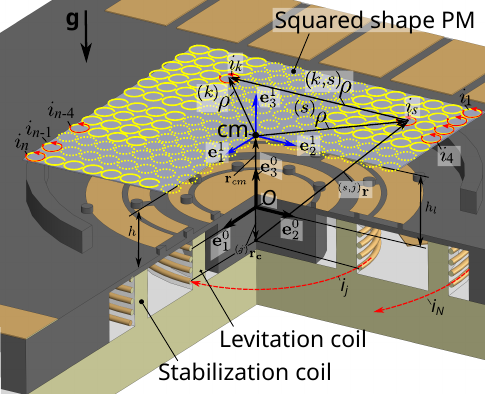
Figure 4. Scheme for the simulation: e 0 is the fixed base; g is the gravity acceleration vector directed along the e 0 -axis; e 1 is the base assigned to the center of mass (cm) of the PM; i j is the current in 3 the j -circular loop of the coil; h is the levitation height estimated from the surface of the electrode structure; h l is the levitation height estimated from the top first winding of the coils.